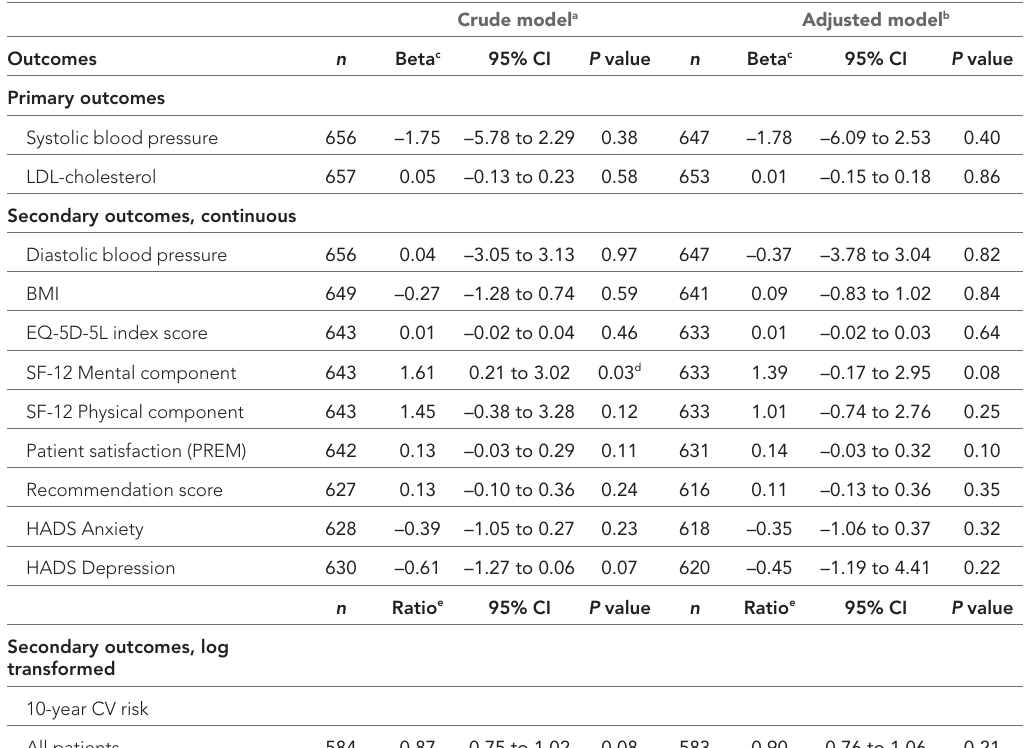
Table 3 Effect of integrated CVRM care on the primary and secondary outcomes compared with usual care, using generalised mixed- model